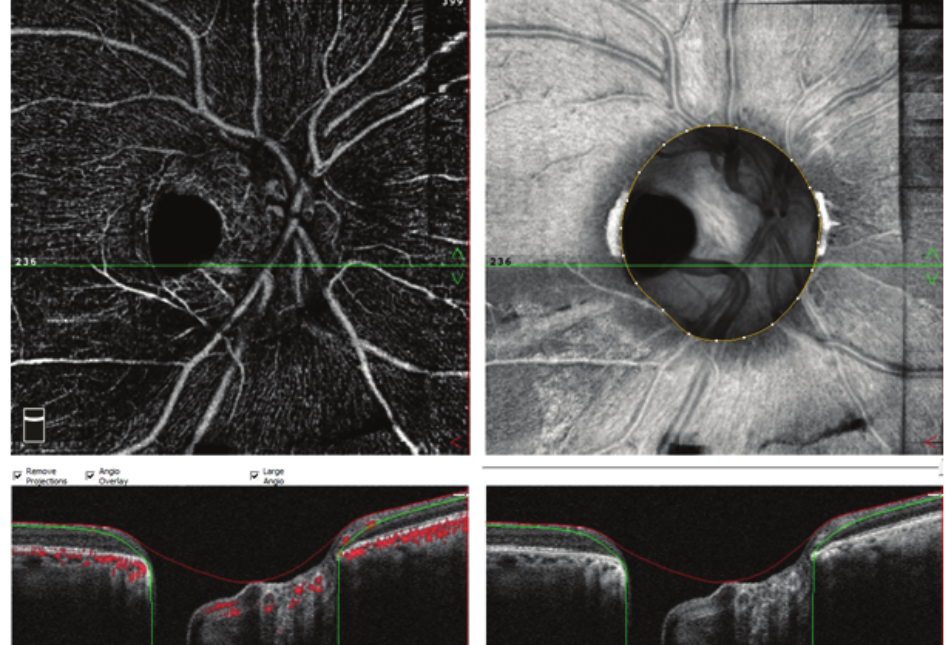
Figure 4. Optical coherence tomography angiography demonstrates cavitation in the disc stroma and a retinochoroidal vein that sinks into the pit of the optic nerve (PON) at the level of the superficial capillary plexus in the right eye.